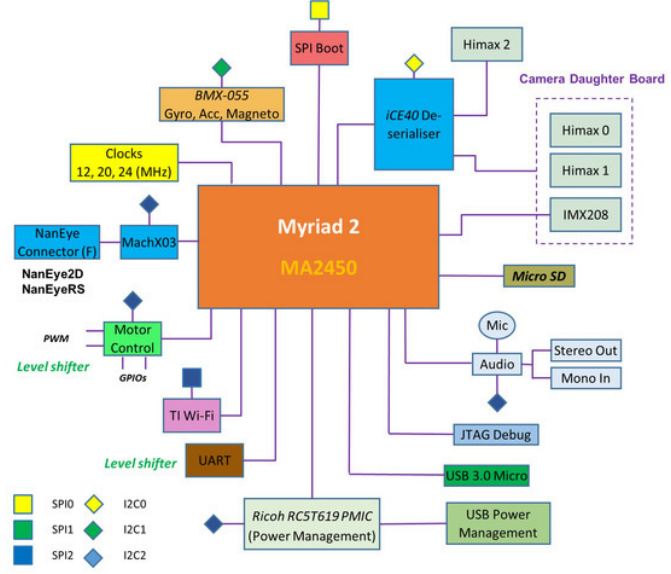
Figure 3. EoT block